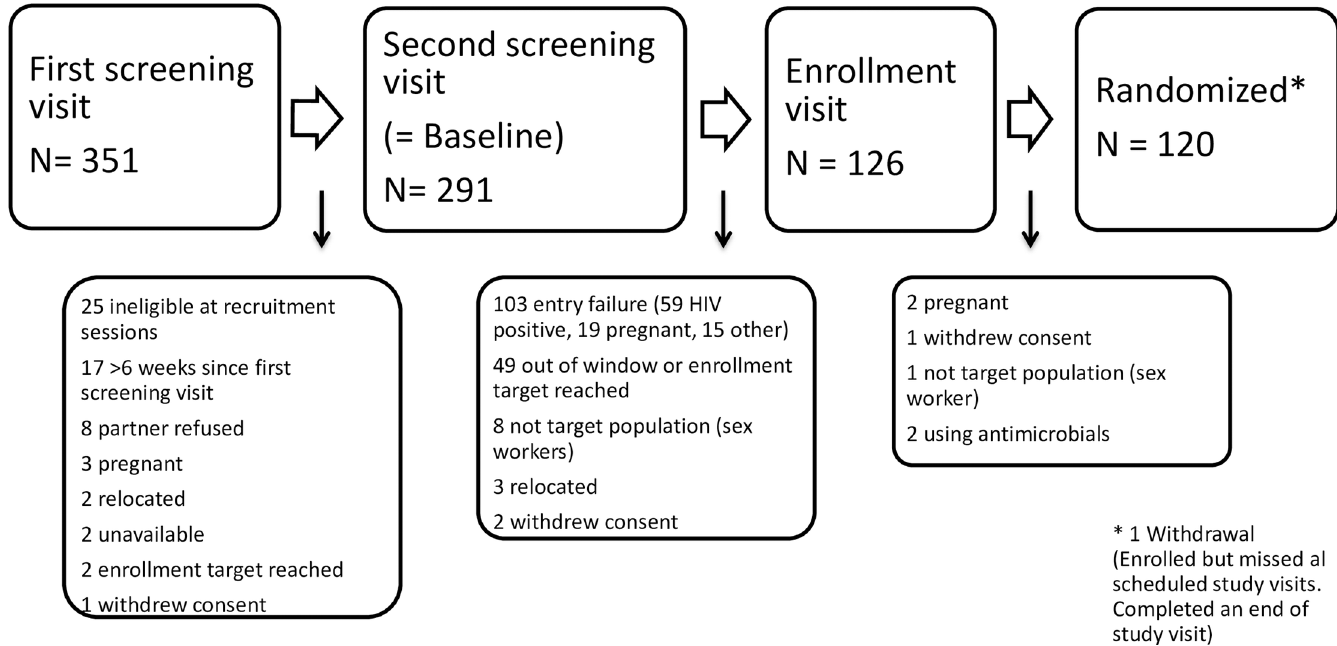
Fig 1. Flow chart of the study process detailing screen failure rates. The study screen flow is presented detailing screen failure rates.